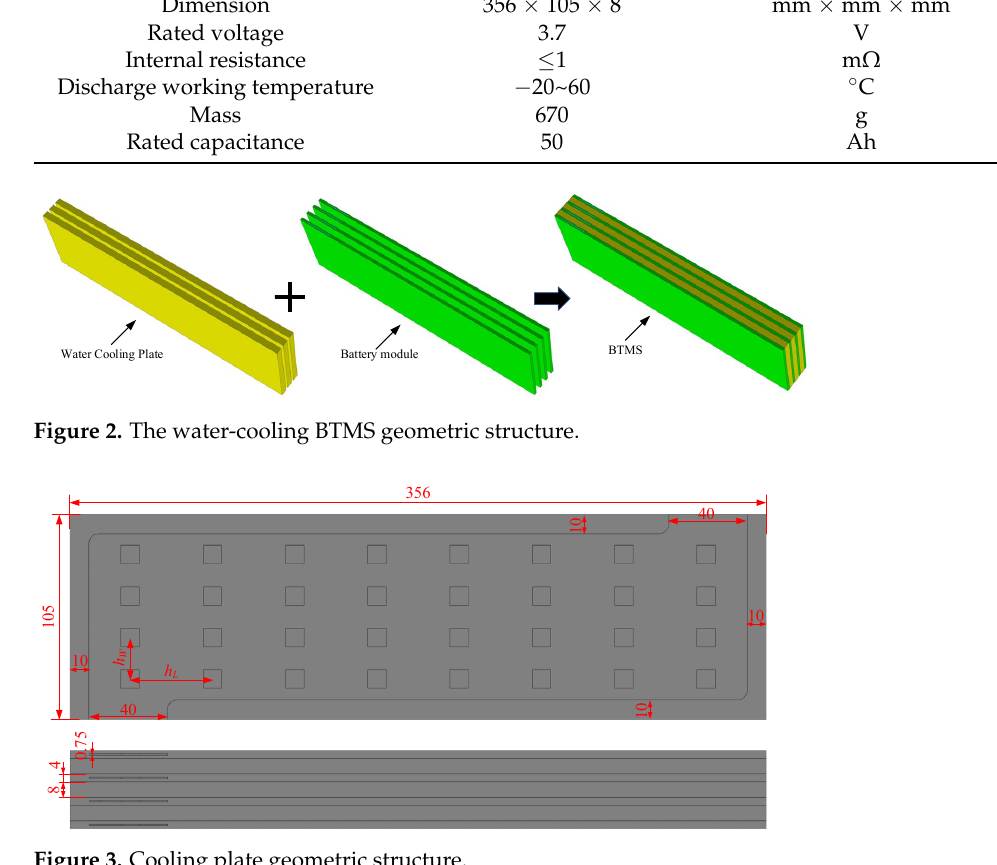
Figure 3. Cooling plate geometric structure.